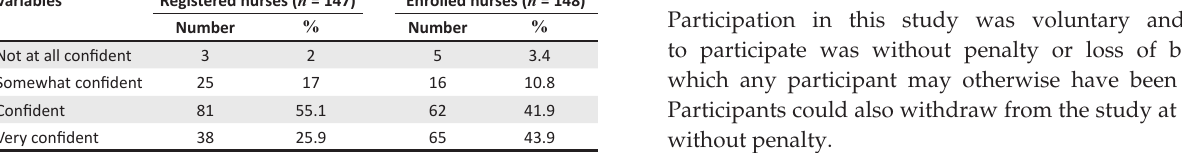
TABLE 6: How confident are you that your patients are able to manage their care when discharged? Variables